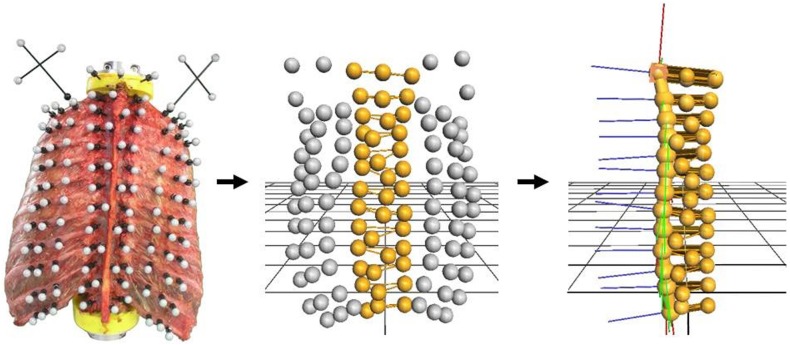
The process of motion analysis.Optical markers were transferred into a point cloud. Relative motions were determined by manual labeling.